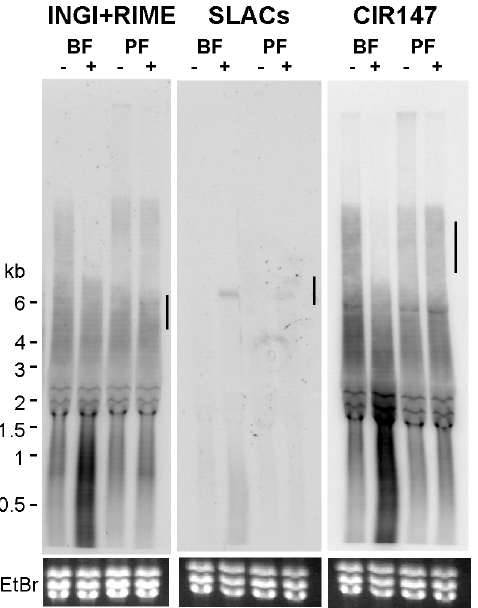
Figure 6. Effect of RBP33 depletion on the levels of transcripts derived from retroposons and CIR147 repeats. Probes designed to detect both INGI/RIME-derived transcripts, SLACs retroposons or CIR147-derived transcripts were used in Northern hybridizations as described in Fig. 5 legend. Ethidium bromide staining was used as a loading control. Vertical lines indicate the expected migration of the corresponding transcripts upon disruption of the RNAi machinery observed in